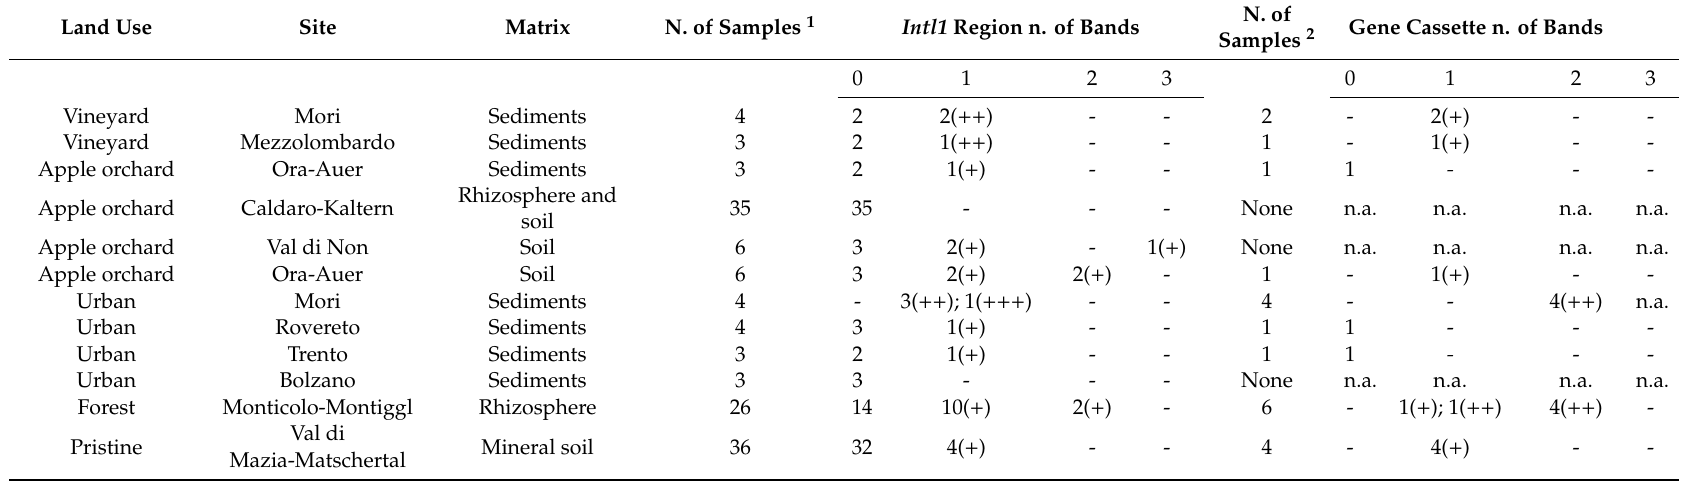
Table 2. Land use, site, matrix, N. of samples 1 (number of analyzed samples) and N. of samples 2 (number of positive samples) and the number of bands and their intensity ( Intl1 region n. of bands and gene cassette n. of bandsranging from null to three detected bands) obtained by intl1 and gene cassettes. ( + = low intensity; ++ = medium intensity; +++ = high intensity; n.a. = not applicable; - = not